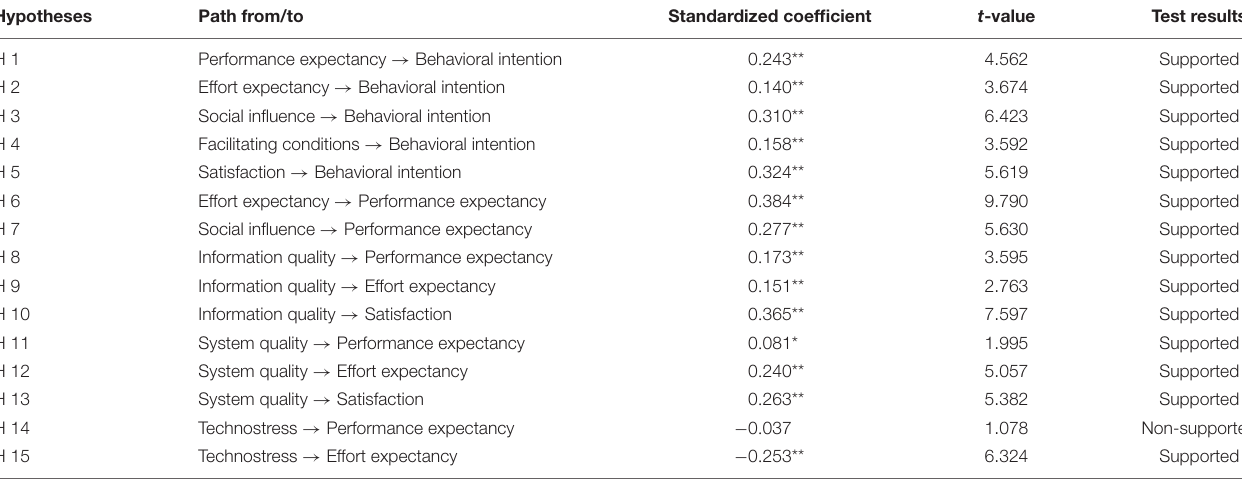
TABLE 3 | Estimation results for Hypotheses 1 to 15.